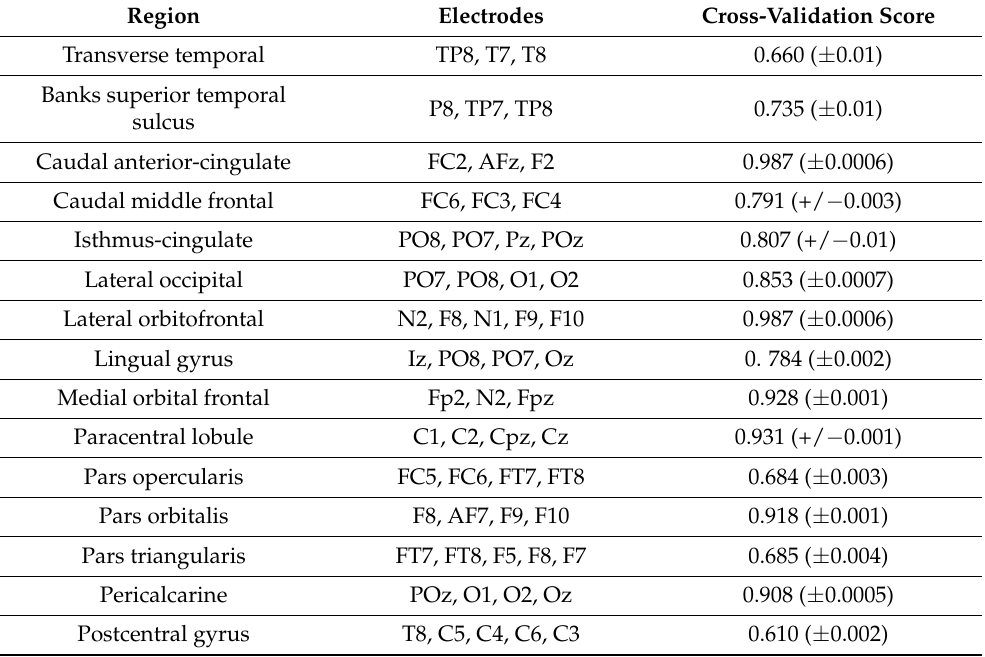
Figure 1. Classificatory accuracy comparison between time-window span. p -value annotation legend: ns: non-significant; **** p < 0.0001; diamonds points represent outliers. Table 1. Associated regions and electrodes as an exploratory baseline. In bold, the regions and the electrodes with the highest validation